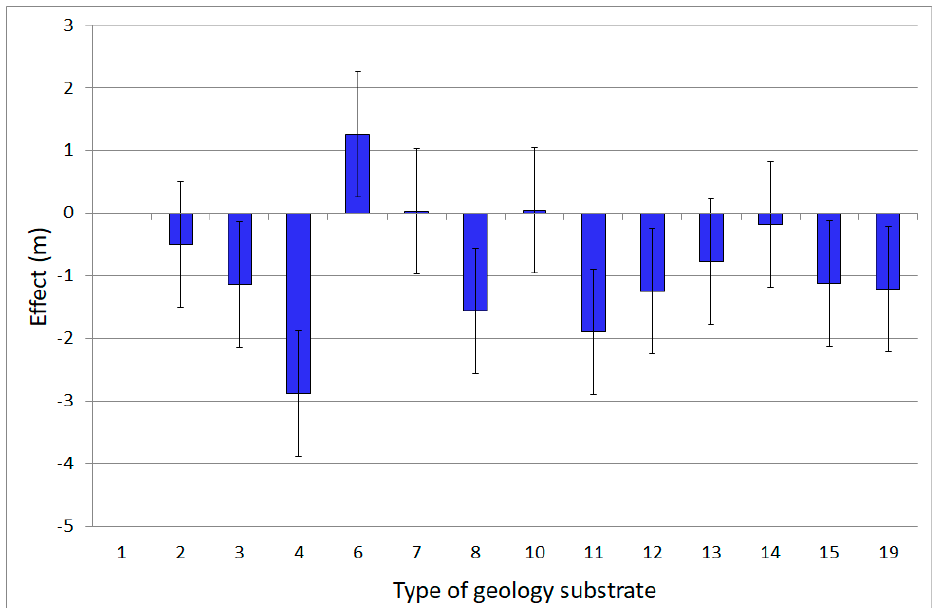
Figure 5. The geological substrate partial effects on the site index for oak; the effect is displayed with all other factors held constant. Legend: 1—Quaternary aeolian sand; 2—Quaternary sand and residual gravel with boulders; 3—tertiary Neogene Krakowieckie clay; 4—Quaternary South Polish Pleistocene sand, silt, and gravel; 5— Quaternary Pleistocene glacial